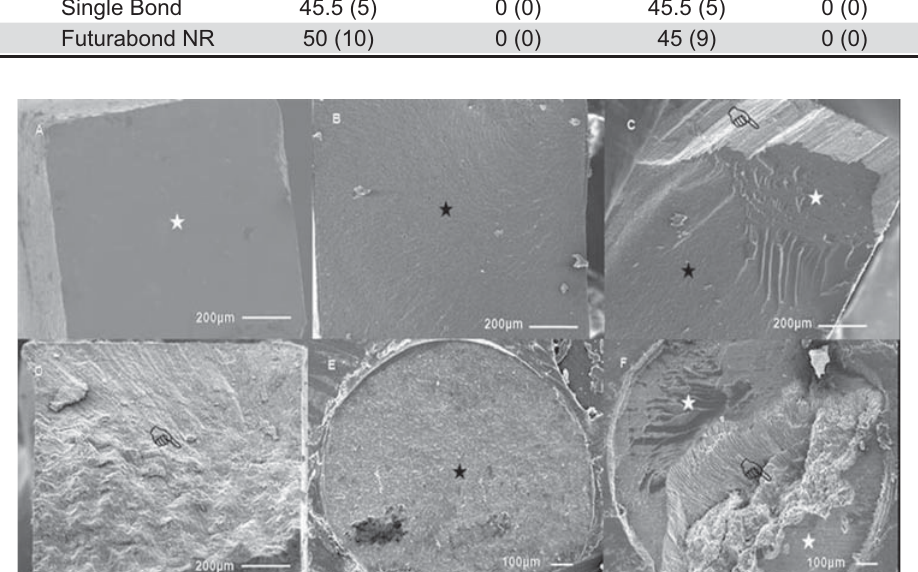
Figure 2- X(cid:2)(cid:30)(cid:13)(cid:2)(cid:16)(cid:2)(cid:6)(cid:3)(cid:5)(cid:3)(cid:14)Y(cid:2)(cid:10)(cid:29)(cid:17)(cid:12)(cid:13)(cid:2)(cid:16)(cid:10)(cid:7)\(cid:10)(cid:3)(cid:4)(cid:2)(cid:10)\(cid:5)(cid:14)(cid:8)(cid:12)(cid:13)(cid:2)(cid:10)!(cid:7)(cid:15)(cid:2)(cid:16)(cid:10)(cid:7)^(cid:16)(cid:2)(cid:13)Y(cid:2)(cid:15)(cid:10)(cid:14)(cid:6)(cid:10)(cid:3)(cid:4)(cid:2)(cid:10)!(cid:14)(cid:18)(cid:13)(cid:7)(cid:3)(cid:2)(cid:6)(cid:16)(cid:14)(cid:8)(cid:2)(cid:10)<_>>(cid:31)?(cid:10)<(cid:25)(cid:22)(cid:27)?(cid:10)(cid:5)(cid:6)(cid:15)(cid:10)!(cid:14)(cid:18)(cid:13)(cid:7)(cid:16)(cid:4)(cid:2)(cid:5)(cid:13)(cid:10)<(cid:19)‘>(cid:31)?(cid:10)<(cid:28)(cid:22){?(cid:10) tests. In (A), one can see an adhesive fracture pattern (white star). (B) and (E) represents cohesive resin failure. Black star shows resin composite in the same surface of both fractured specimens. (C) and (F) are mixed failures. Enamel is represented by the pointer, adhesive by the white star and resin composite by the black star. (C) represents a cohesive failure in enamel